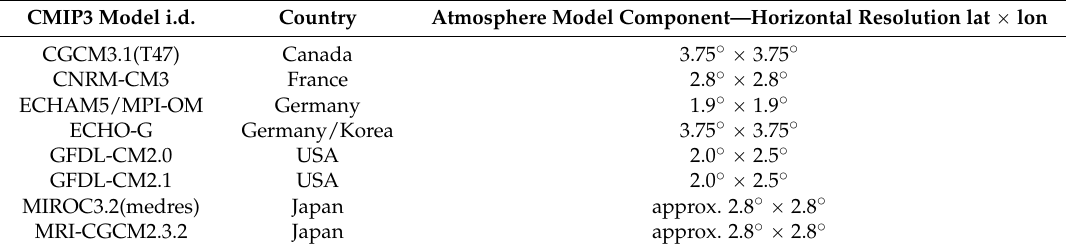
Table 4. Details about the GCMs used in the